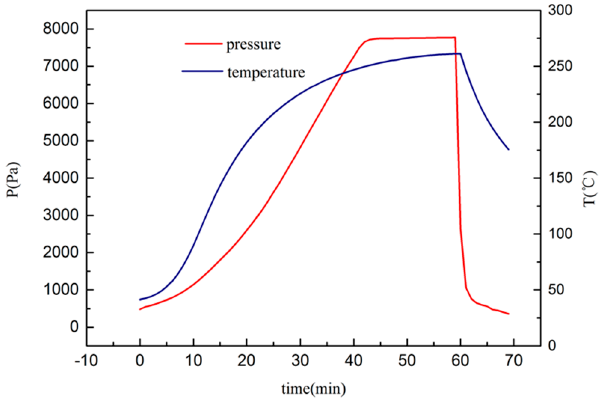
Figure 6. Variation of temperature and pressure in the process of thermal vacuuming.